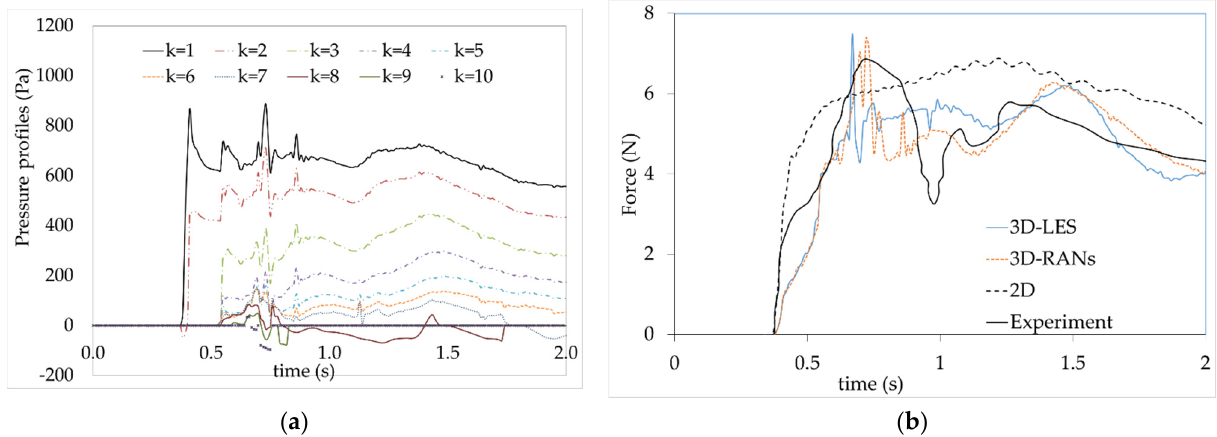
Figure 2. ( a ) Distributed pressure profiles at centerline of front face of column; ( b ) Comparison of load-time histories simulated by different numerical models.